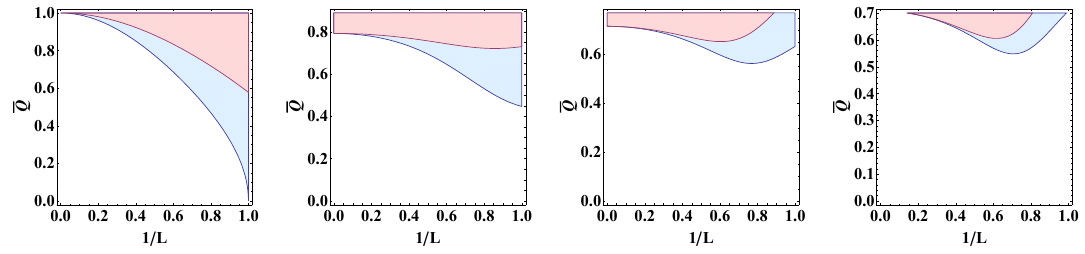
Figure 8 . The unstable regions of the de Sitter charged Gauss-Bonnet black hole for (cid:11) (cid:21) (cid:0) 1 = 2. From the left to the right (cid:11) = 0 ; (cid:0) 0 : 2 ; (cid:0) 0 : 4 and (cid:0) 0 : 5, respectively, where the light red region corresponds to ‘ = 3 and the light red region plus the light blue region correspond to ‘ =